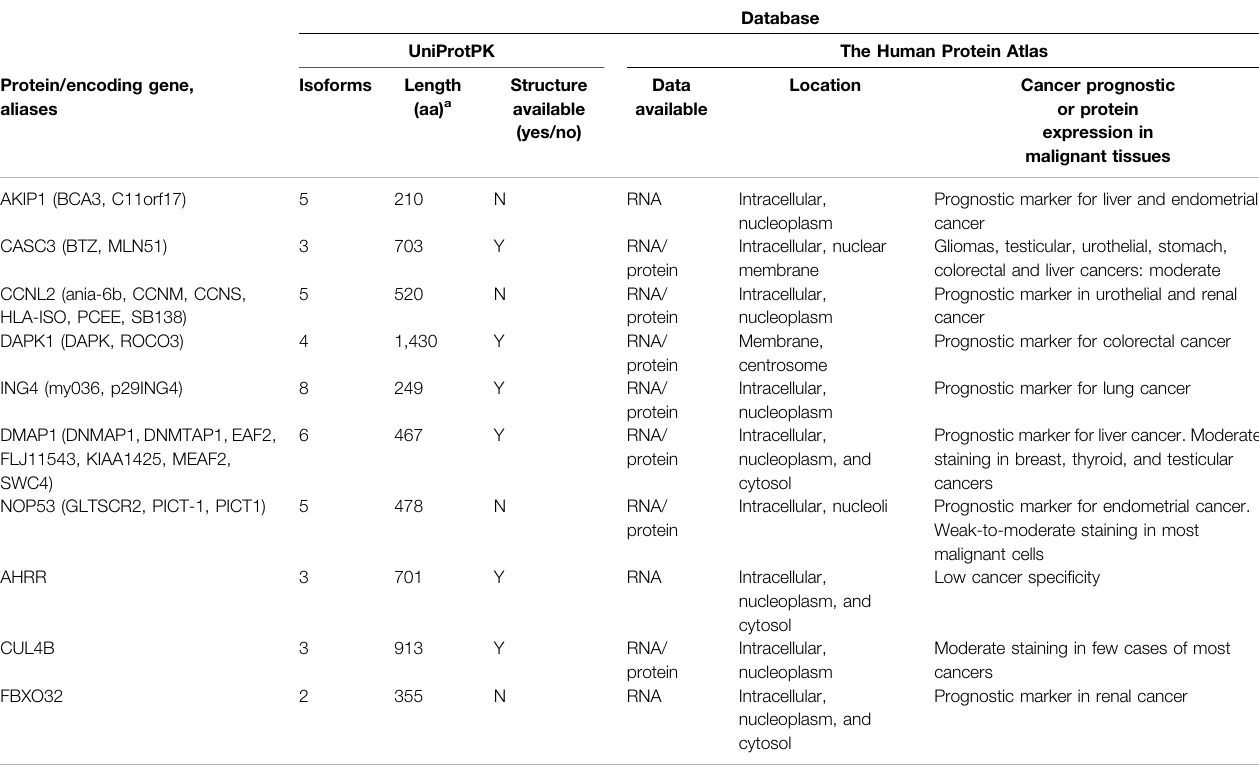
TABLE 1 | Chosen proteins and parameters (data from UniProtPK or The Human Protein Atlas).